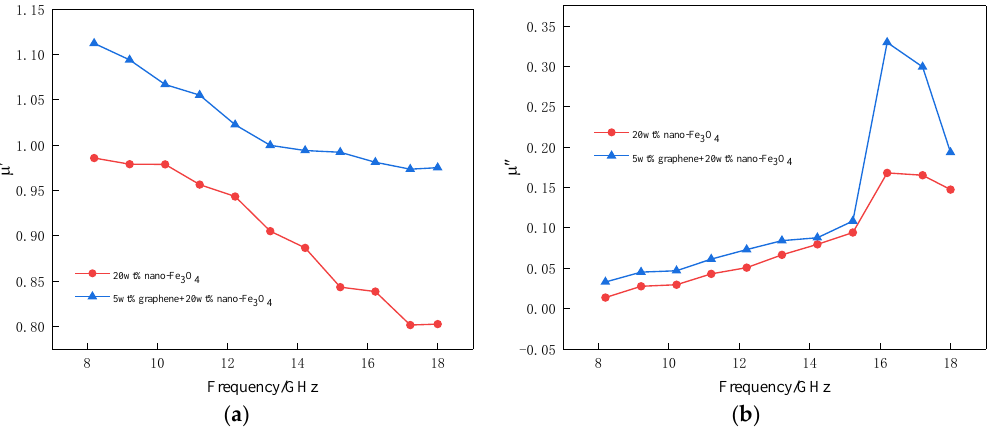
Figure 10. Complex permeability of composite absorbers with different absorbing agent composition. ( a ) The real part of the complex permeability; ( b ) the imaginary part of complex permeability.